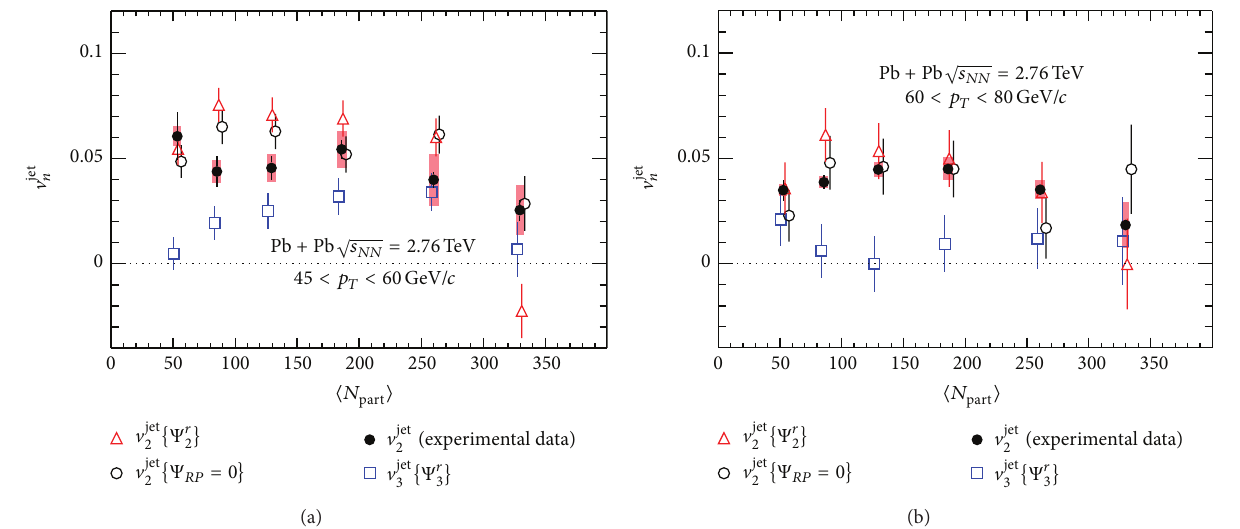
Figure 10: V jet 𝑛 ( 𝑛 = 2 and 3) as a function of 𝑁 for jet 𝑝 𝑇 bins of 45 < 𝑝 𝑇 < 60 GeV/c (a) and 60 < 𝑝 𝑇 < 80 GeV/c (b) in Pb + Pb collisions part at √𝑠 𝑁𝑁 = 2.76 TeV, where open triangles represent V jet 2 with respect to Ψ 𝑟 2 , open circles represent V jet 2 with respect to Ψ 𝑅𝑃 = 0, open squares represent V jet 3 with respect to Ψ 𝑟 3 , and solid circles represent the ATLAS experimental data [17]. Some points are slightly shifted along the 𝑥 -axis for better